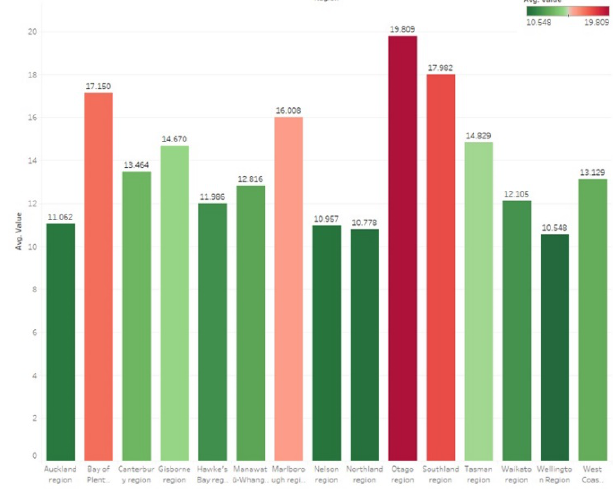
Figure 2. The average PM10 values of regions in